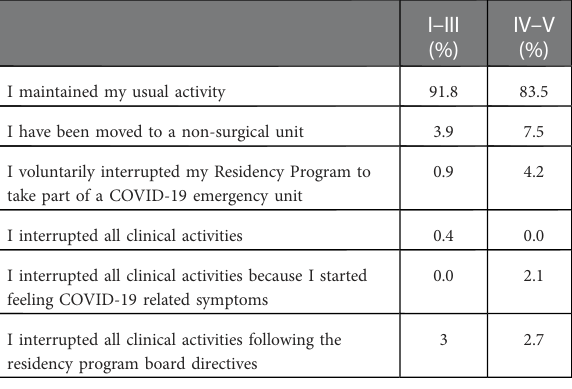
TABLE 4 Impact of pandemic on clinical, surgical and research activities. Impact of COVID-19 second wave on clinical activities (378)